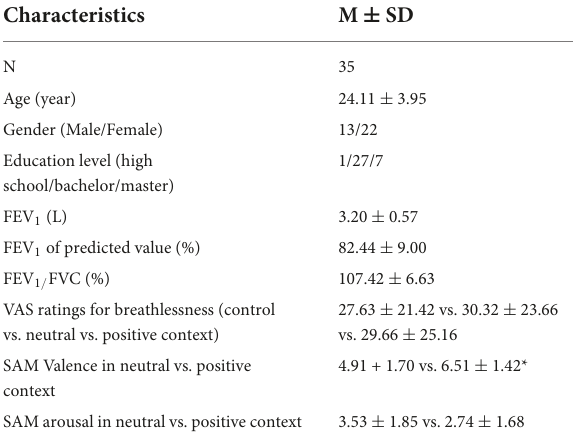
TABLE 1 Baseline characteristics and self-reported